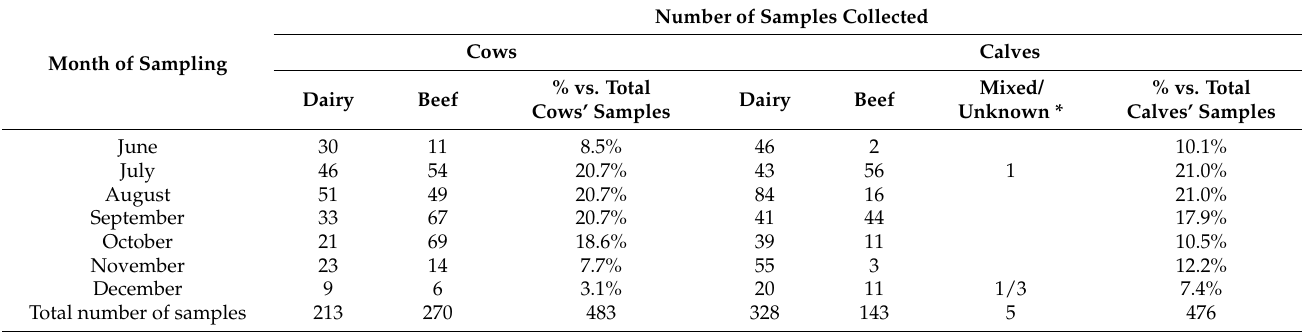
Table 1. Number of cattle intestinal samples studied in this work, distributed by the month of sampling, age of cattle (cows and calves) and productive aptitude (dairy and